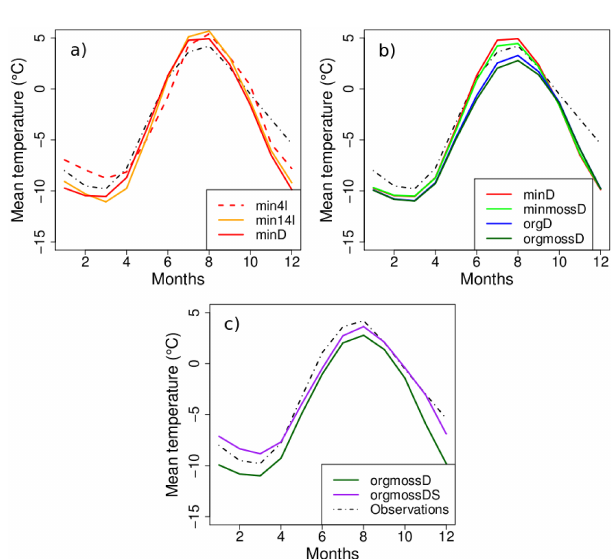
Figure 6. Comparison of annual cycle of soil temperatures at 90cm depth, from the Russian historical soil temperature and IPY-TSP data (Sect. 2.4.4) and JULES simulations.